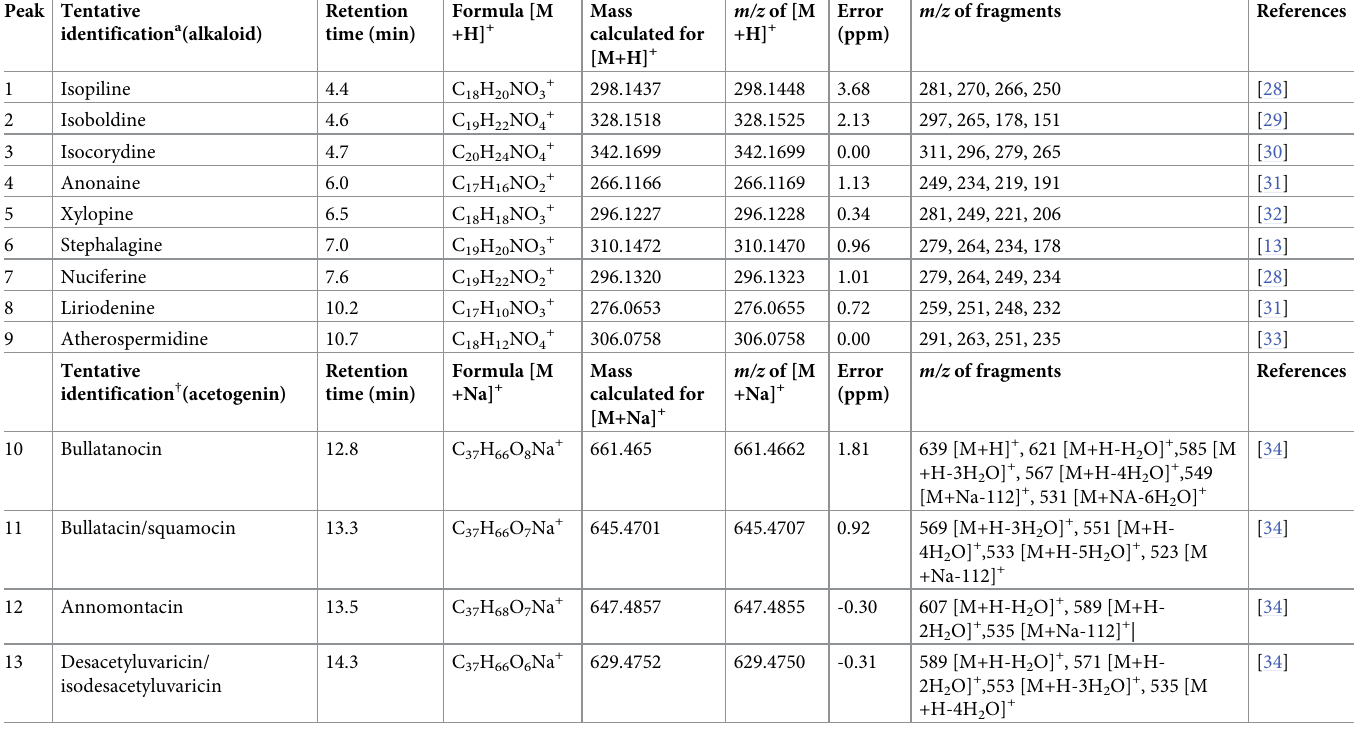
Table 1. Alkaloids and acetogenins identified in the alkaloid and acetogenin-rich fraction from Annona crassiflora fruit peel (AF-Ac) by UHPLC-ESI/MS n (positive mode). Peak Tentative identification a